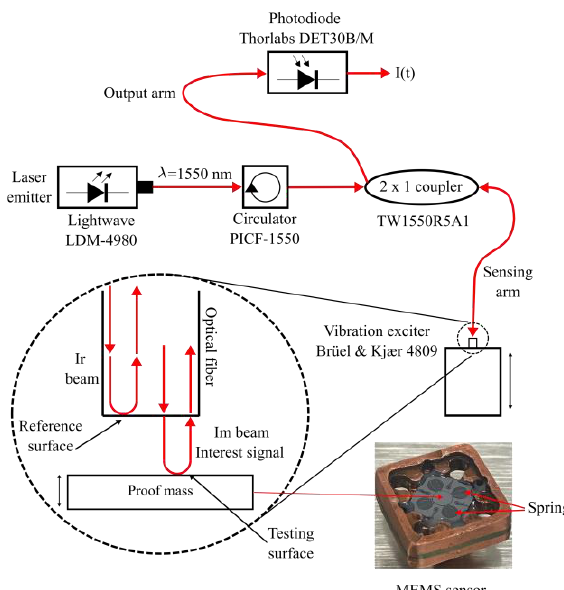
Figure 1. Optical setup showing the components of the Michelson interferometer, the vibration exciter, and the proof-mass MEMS [27].